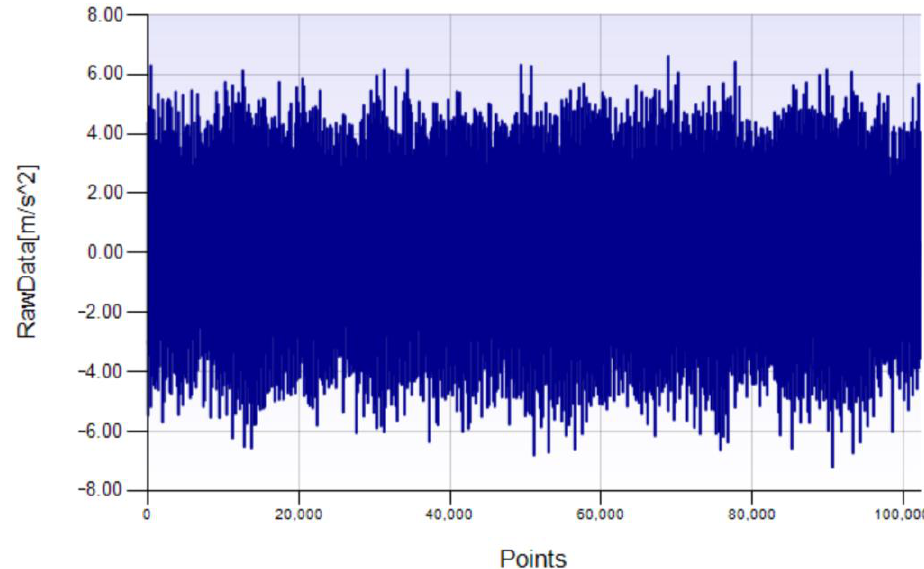
Figure 10. Time domain diagram of vibration signal at the medium-speed shaft position in the gearbox of wind turbine A under normal conditions.